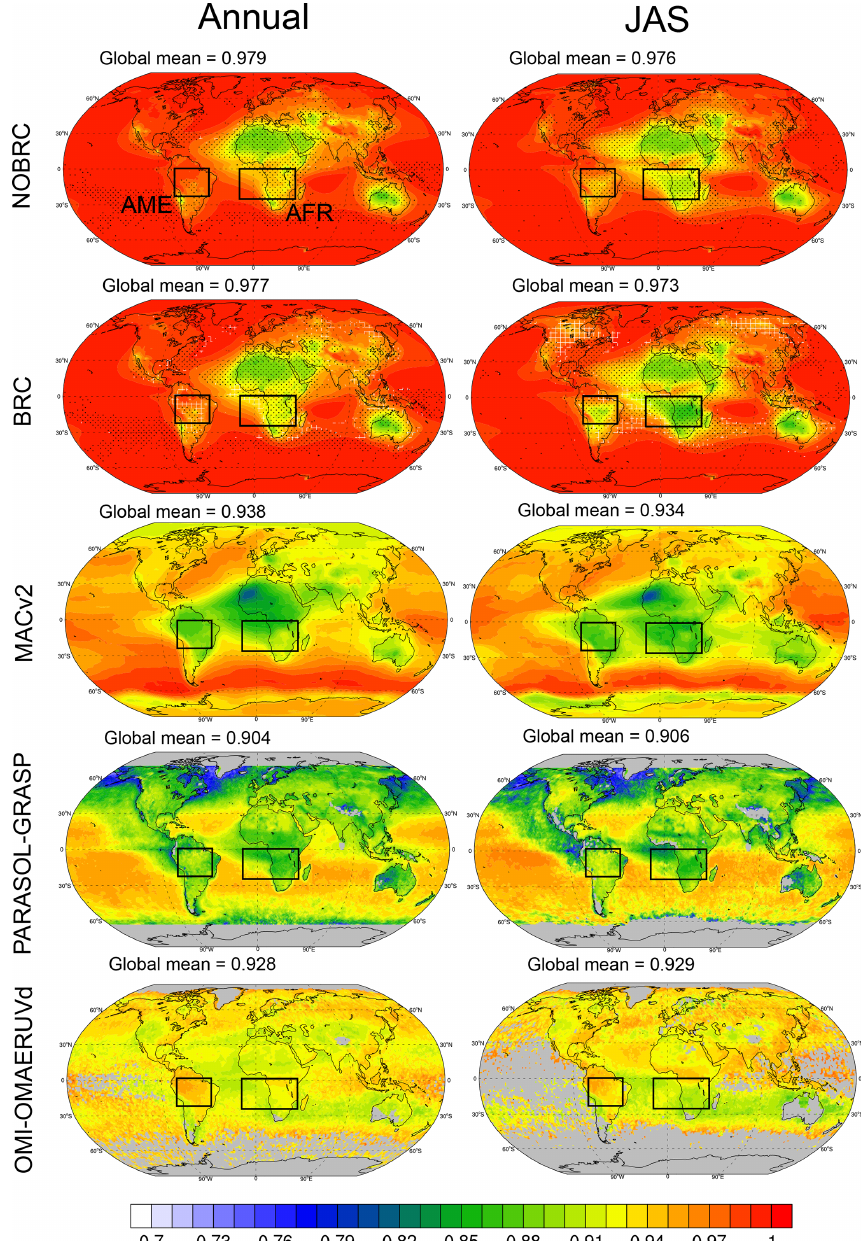
Figure 9. Same as Fig. 8 but for the SSA at 440nm (see Tables 2 and 3 for details).